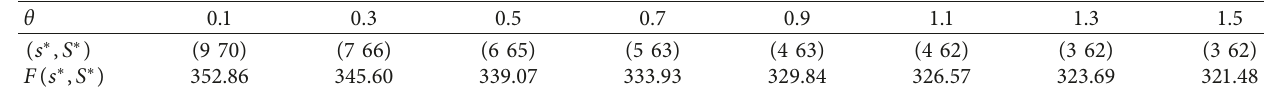
Table 3: The effect of the parameter θ on the optimal policy and the optimal cost.